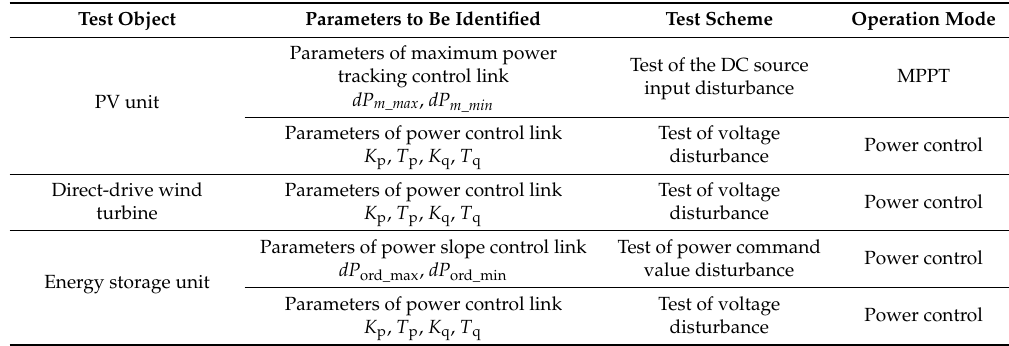
Table 1. Parameters to be identified and test scheme of the renewable power sources.